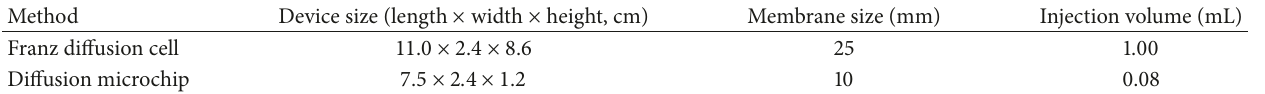
Table 1: Size difference between the traditional transdermal drug delivery and diffusion microchip system.